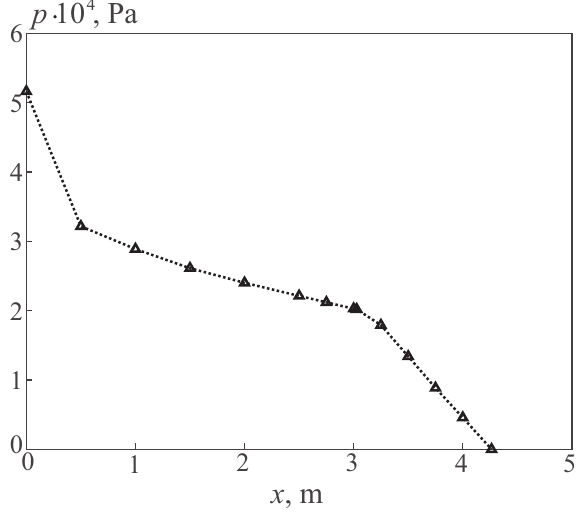
Figure 13. Distribution of cross-section averaged oil pressure. The change in the friction loss coefficient along the length of the pipe is shown in Figure 14. The coefficient of the friction is calculated locally on a certain interval using the relation ∆ p / ∆ x ) / ( ρ v 2 ) , where ∆ x is the distance between two points, in which the pressure is measured, and ∆ p is pressure difference at these